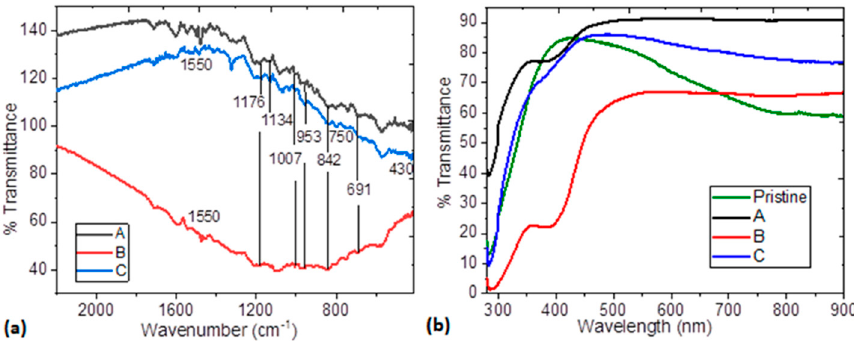
Figure 4. ( a ) IR spectra of MoO 3 /PEDOT:PSS-organotin (IV), ( b ) Transmittance spectra of pristine MoO 3 /PEDOT:PSS and MoO 3 /PEDOT:PSS-organotin (IV) complex films. Table 2. Band positions and assignments of MoO 3 /PEDOT:PSS-organotin (IV) complex films. Assignment